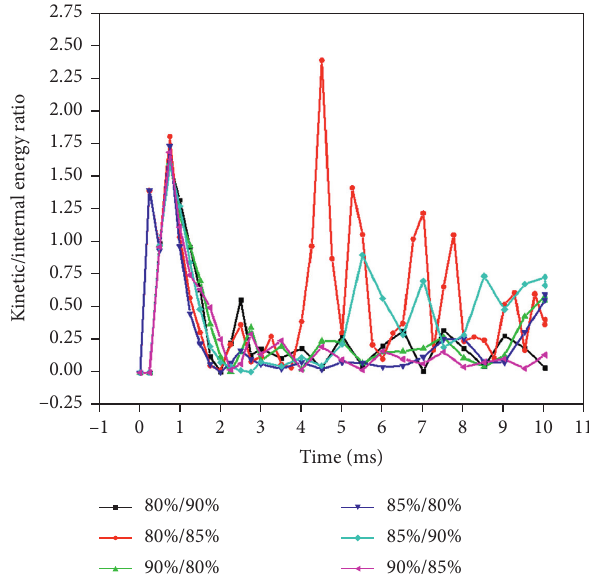
Figure 12: Energy ratio of aluminum